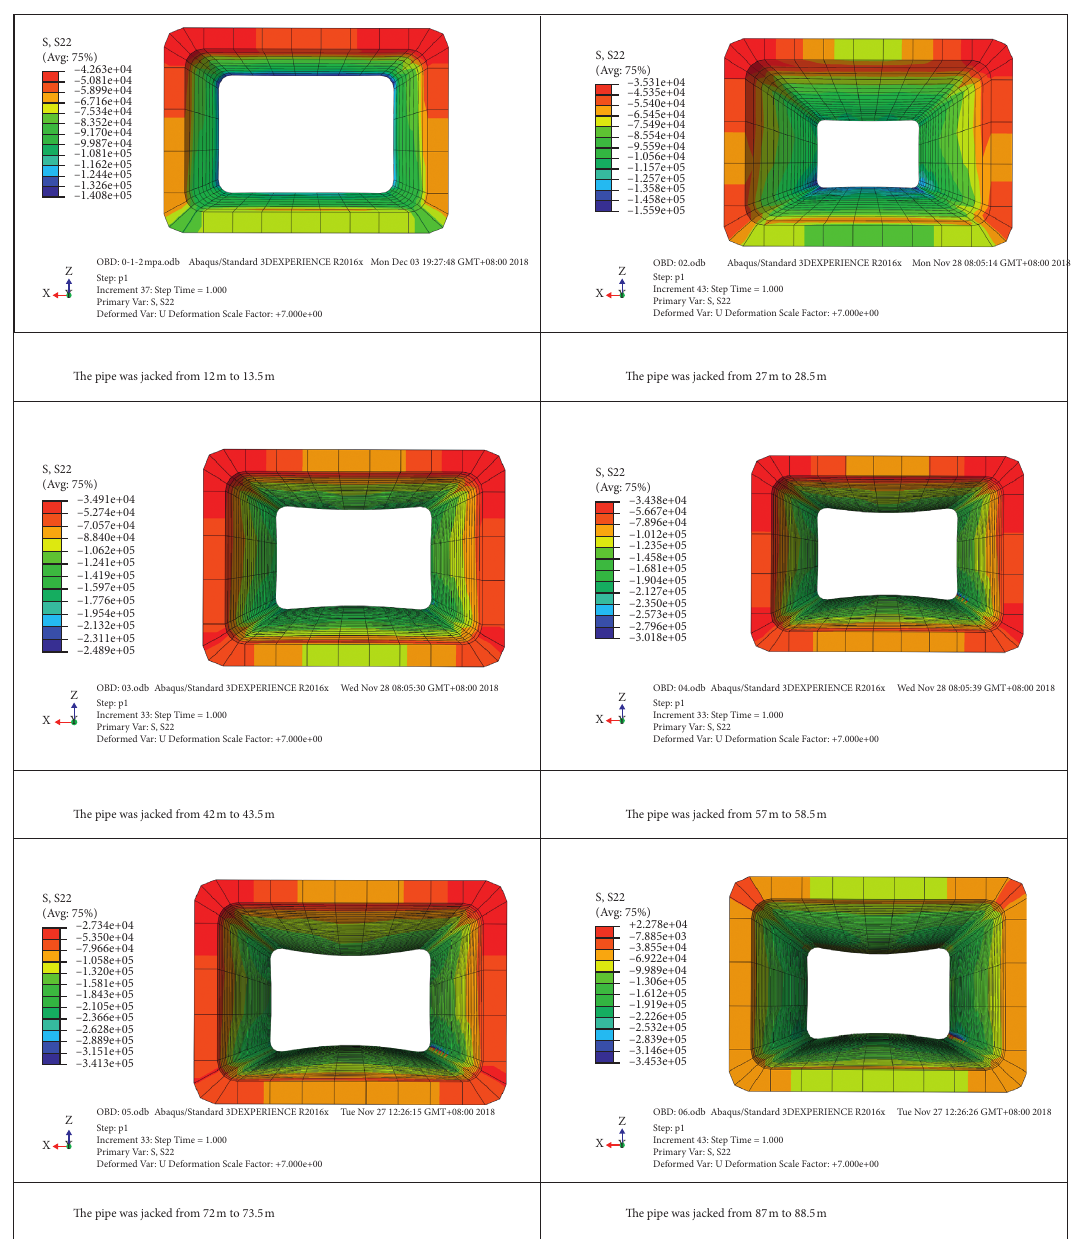
Figure 6: The distribution of σ